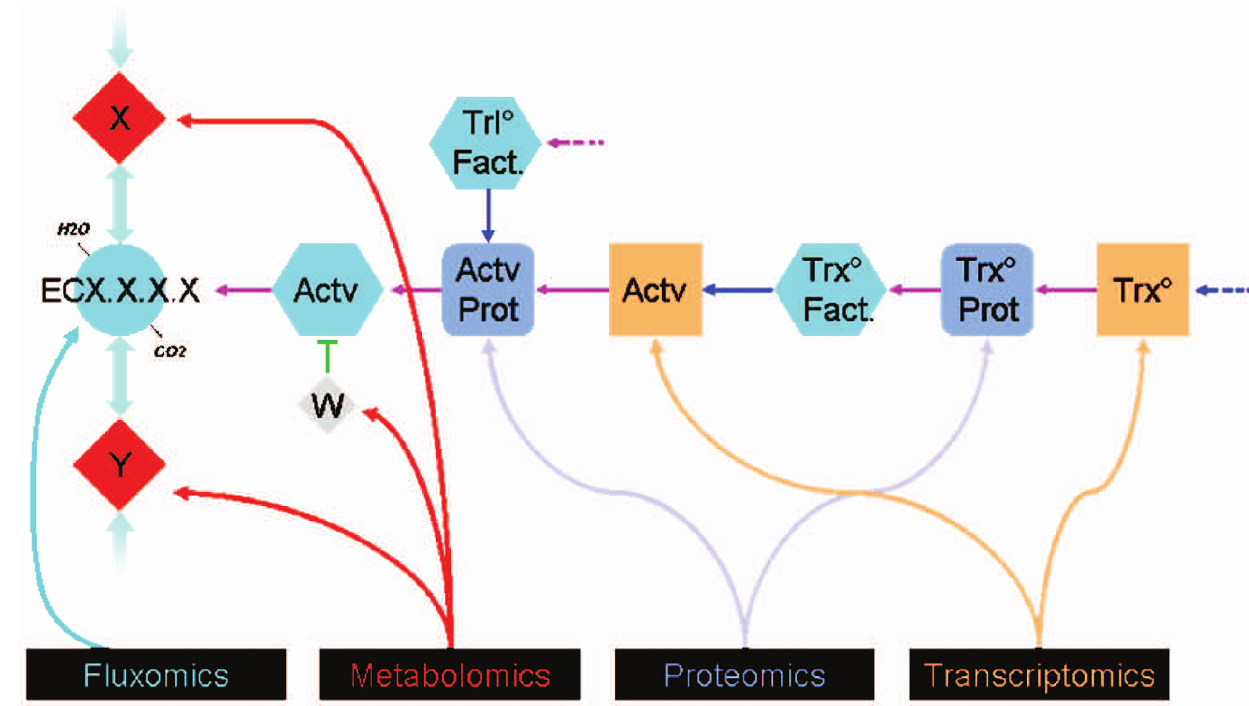
Figure 1. Dedicated formalism. All molecular or functional components of the metabolic and regulatory networks are explicitly represented using specific symbols. Each RNA (square) encodes a polypeptide (rounded square). Polypeptides or polypeptide complexes generate functional entities – i.e ., enzymes or regulators – (hexagons). Enzymes catalyze reactions (circles), which allow the inter-conversion of metabolites (diamonds). A color code can be applied to each node (symbol) in the network to visualize experimental data (gene expression for the squares, protein abundance for the rounded squares, specific activity for the hexagons, metabolite concentrations for the diamonds and flux values for the circle). Interactions between the components are indicated with lines (edges). Four main kinds of interactions were considered and were represented using lines with specific colors: biochemical conversions (grey lines), transcriptional and translational regulations (blue lines), control of enzymatic activities by metabolic effectors or by phosphorylation (green lines), hierarchical relationships – i.e. RNAs to proteins, proteins to activities, activities to reactions - (pink lines). In the given example, a metabolite X is converted in Y through the reaction ECx.x.x.x. The reaction requires a molecule of H 2 O and produces a molecule of